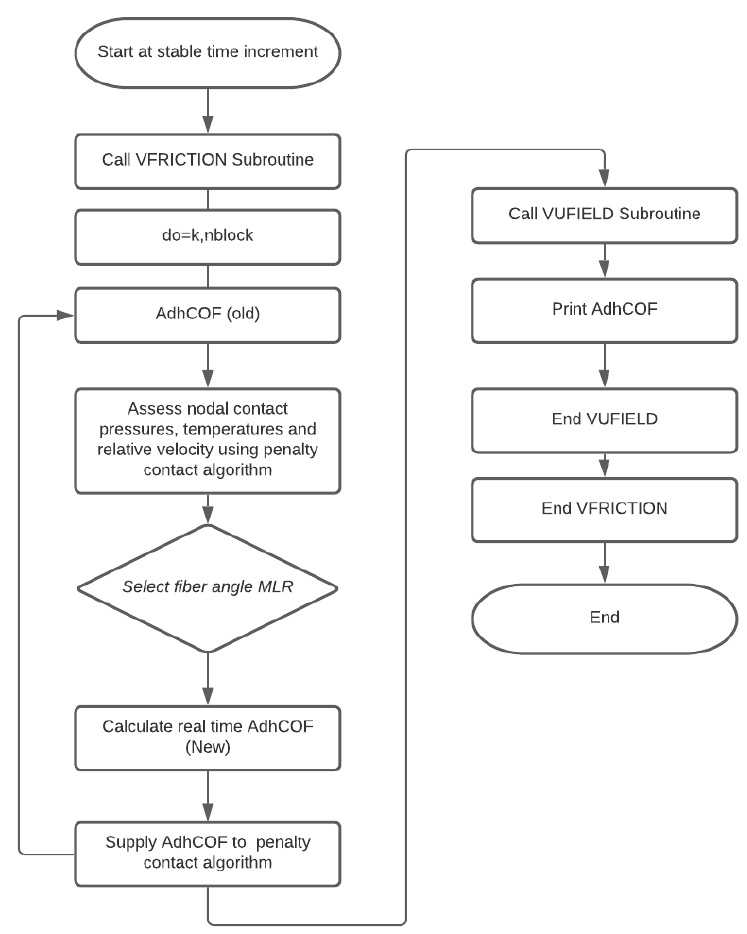
Figure 10. Subroutine